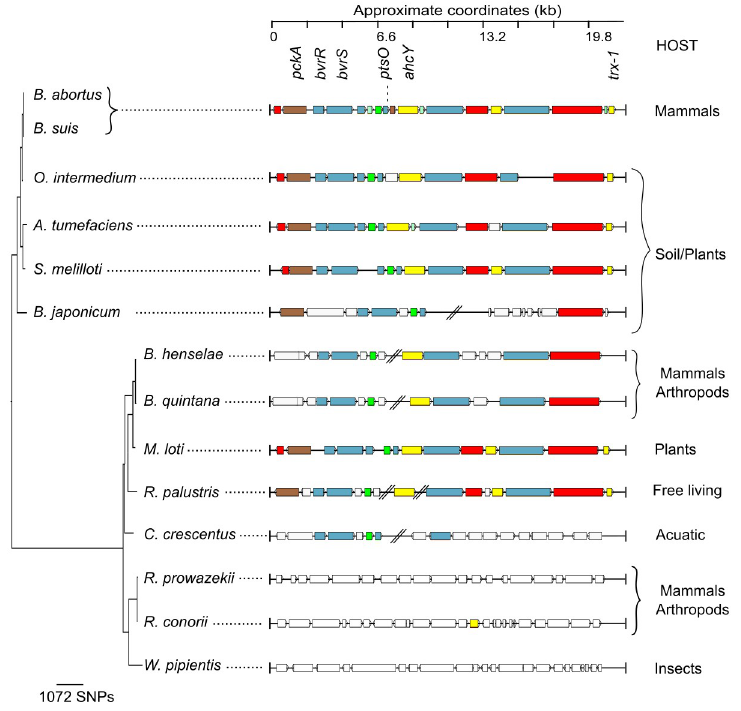
Fig 2. BvrR/BvrS operon synteny analysis within representative Alphaproteobacteria . Genes of B . suis 1330 were compared to representative genomes by BLAST and visualized through ACT. Blocks of different colors show the aligned coding sequences (CDs): grey—energy metabolism; red—information transfer (transcription/translation + DNA/RNA modification); green—surface (IM, OM, secreted, surface structures); pink -degradation of small molecules; light blue—regulators; orange—conserved hypothetical. CDs with no similarity with B . suis 1330 are white- colored. A Maximum Likelihood phylogenetic reconstruction based on the 16S rRNA gene was used to infer the evolutionary history of Alphaproteobacteria . The analysis involved 17 nucleotide sequences; the outgroup was trimmed from the tree to enhance resolution. There were a total of 1191 positions in the final dataset.